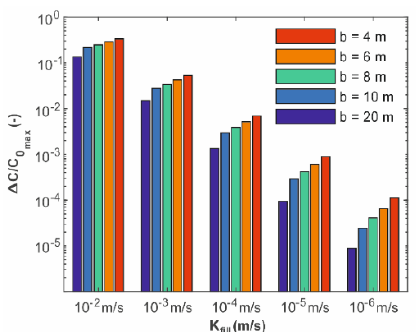
Figure 6. Maximum values of Δ𝐶/𝐶 0 reached in the observation point 200 m downstream the borehole, for different values of 𝐾 𝑓𝑖𝑙𝑙 and 𝑏′ .